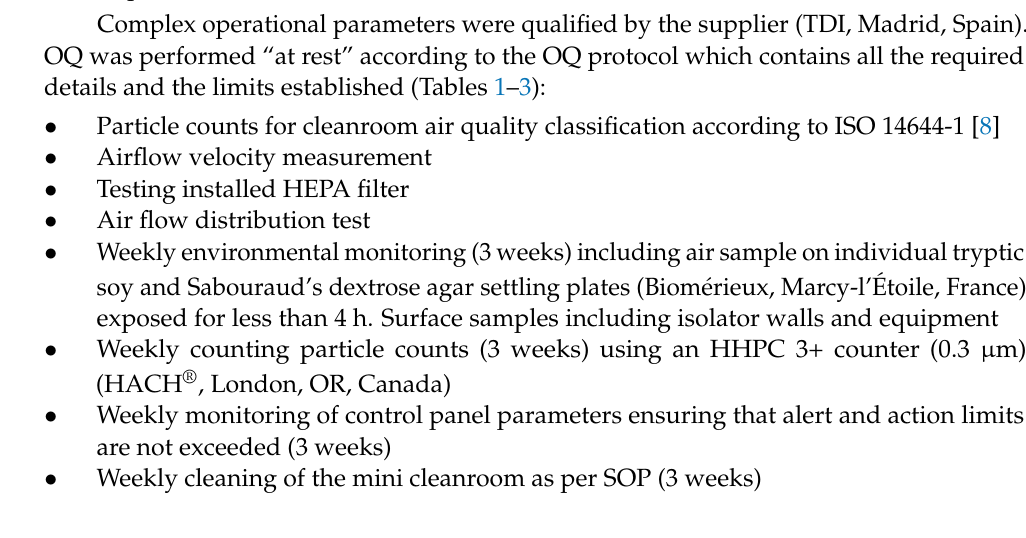
Table 1. Established alert and action limits for control panel parameters.